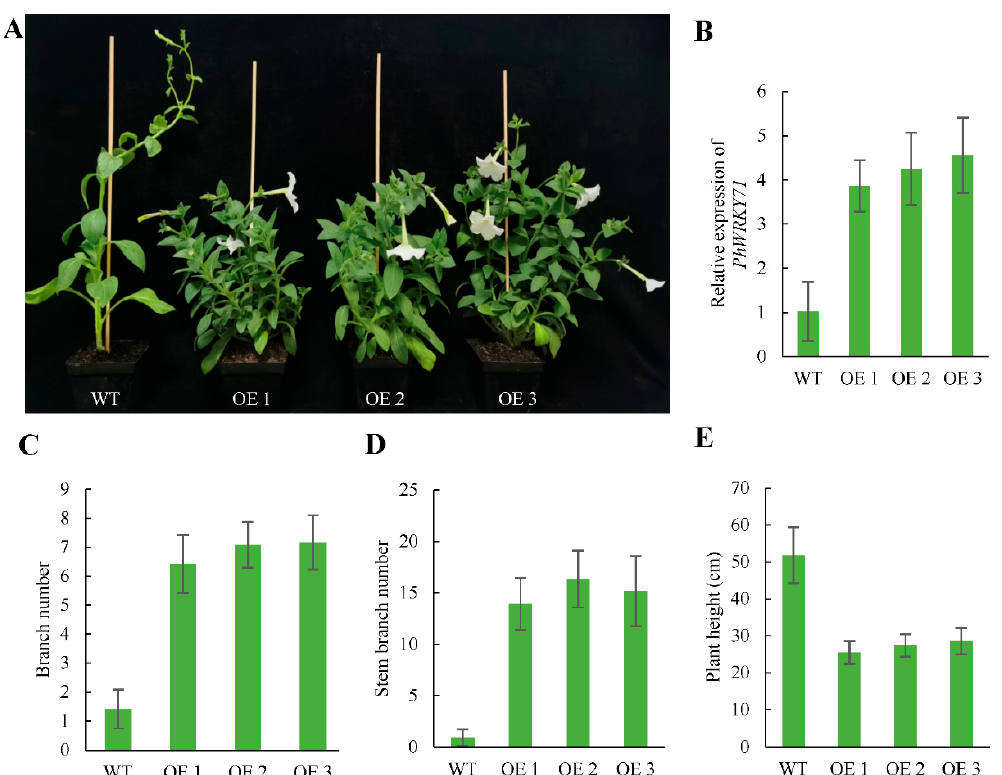
Figure 7. Phenotype and gene expression analysis of transgenic Petunia × hybrida cv ‘Mitchell Diploid’ plants overexpressing PhWRKY71 . ( A ) Phenotypic comparisons of WT and transgenic plants overexpressing PhWRKY71 . OE 1, OE 2 and OE 3 represent different lines overexpressing PhWRKY71 . ( B ) The expression level of PhWRKY71 was assayed by quantitative real-time–PCR (qRT-PCR). Detection of PhACTIN was used as the control. Three samples with 10 plantlets for each were averaged (±SE). ( C ) The basal branch number for each is shown ( n = 12). ( D ) The stem branch number for each is shown ( n = 12). ( E ) The height of the main stem for each is shown ( n = 12).